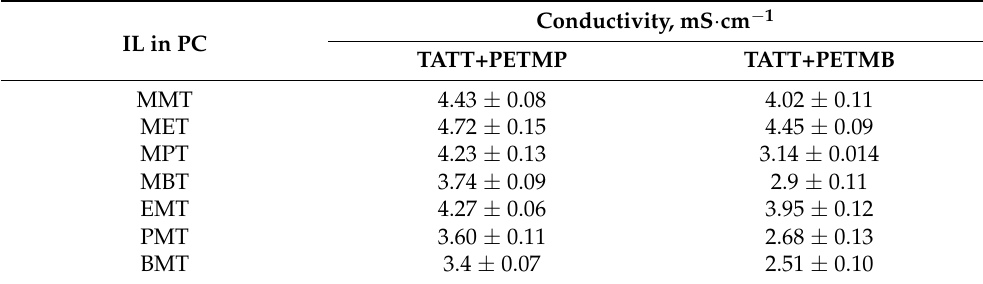
Figure 7. Dependence of ( a ) the maximum polymerization rate, R pmax , ( b ) the normalized R pmax , ( c ) the time to reach R pmax , t max , and ( d ) the final conversion of functional groups, p f on the length of alkyl chain substituent as well as the type of substitution. Filled symbols—PETMP+TATT system; open symbols—PETMB+TATT system. Table 5. Ionic conductivity of IGs with the mixture of IL with PC as electrolyte and different polymer